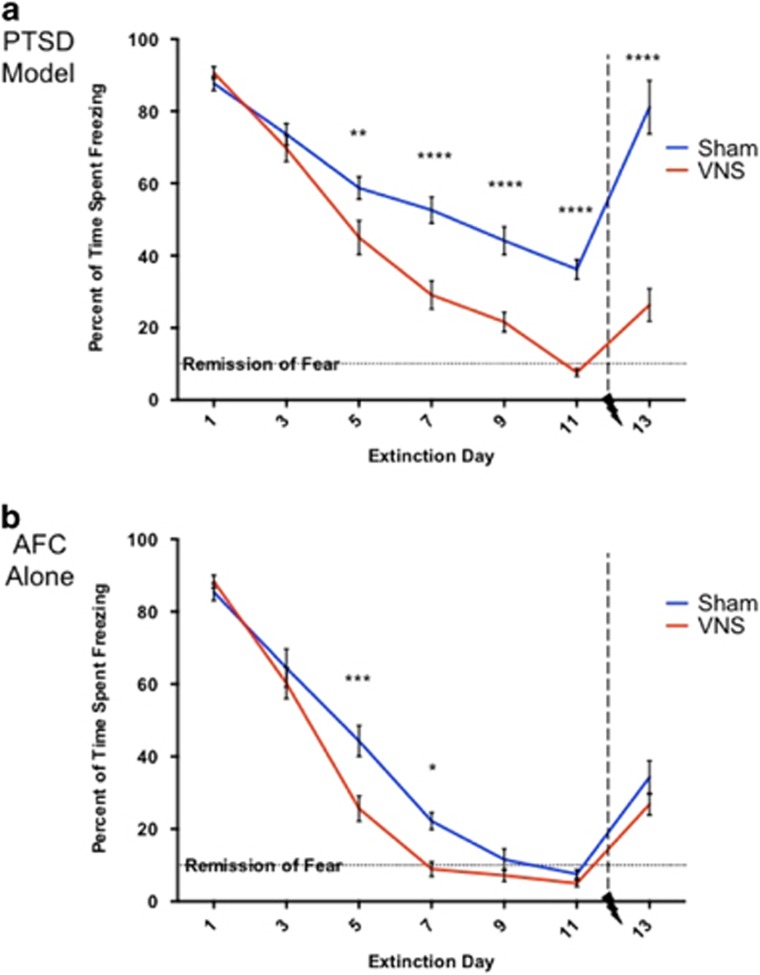
Conditioned fear responding across extinction days. (a) VNS treatment reverses maladaptive fear seen in PTSD model rats. Following 11 consecutive days of extinction, rats exposed to the SPS procedure 1 week before AFC (PTSD model rats) did not reach remission of fear. A single, unpaired reminder of the unconditioned stimulus was sufficient to reinstate conditioned fear to the level of freezing measured on the first day of extinction in the PTSD model. PTSD model rats given VNS reached remission of fear by the end of treatment. VNS also attenuated the reinstatement of conditioned fear. Freezing in rats given VNS was significantly reduced compared with freezing on the first day of extinction. PTSD model rats given VNS showed significantly less fear than sham-treated rats on extinction day 5 (**P<0.01) and extinction days 7, 9 and 11 (****P<0.0001). PTSD model rats given VNS showed reduced reinstatement of conditioned fear versus sham-treated rats (****P<0.0001). (b) VNS treatment accelerates extinction in control rats subjected to AFC alone. All rats that underwent AFC alone reached remission of fear by the end of extinction. VNS led to more rapid remission of fear than sham stimulation. VNS-treated rats showed reduced freezing versus sham-treated rats on extinction day 5 (***P<0.001) and extinction day 7 (*P<0.05). AFC alone rats alone did not show complete reinstatement of conditioned fear following a reminder of the unconditioned stimulus. AFC, auditory fear conditioning; PTSD, post-traumatic stress disorder; SPS, single prolonged stress; VNS, vagus nerve stimulation.